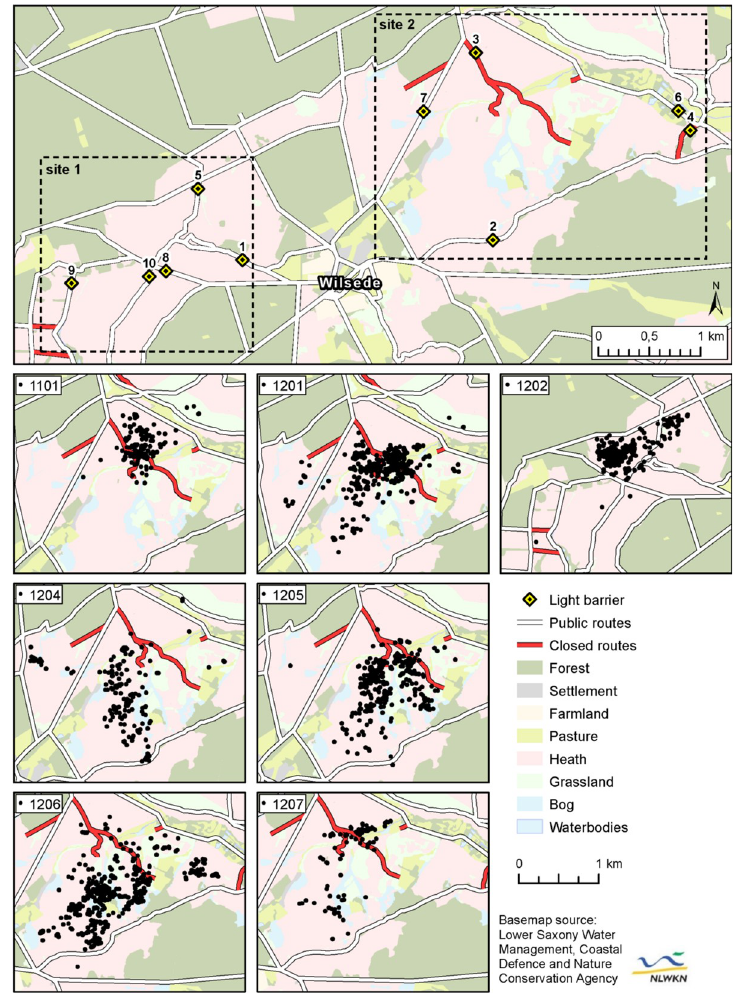
Fig 1. Study area showing sites 1 and 2 and black grouse telemetry data. Overview map (above) shows locations of light barriers alongside hiking trails and closed routes within the study sites 1 and 2. Detailed maps (below) show GPS locations of all seven tagged black grouse